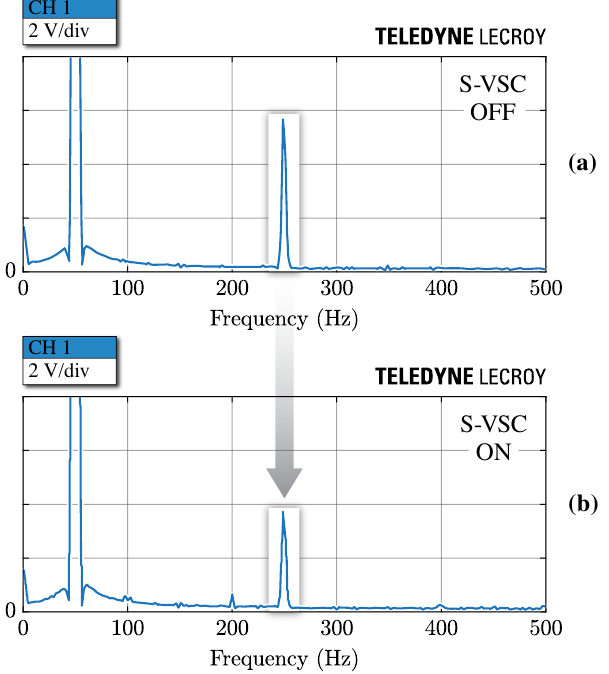
Figure 14. Harmonic compensation test. A 5% 5-th harmonic component is introduced into the emulated grid. A comparison with the S-VSC enabled and disabled is carried out: ( a ) DFT of the voltage at the point of common coupling (PCC) when the S-VSC is off; ( b ) DFT of the voltage at the PCC when the S-VSC is